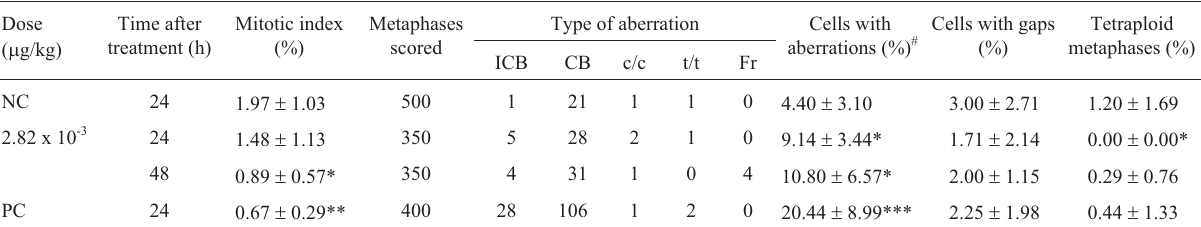
Table 2 - Cytogenetic analysis of mouse bone marrow cells 24 h and 48 h after treatment with Br-oxph (2.82 x 10 -3 (cid:2) g/kg). Dose ( (cid:2)